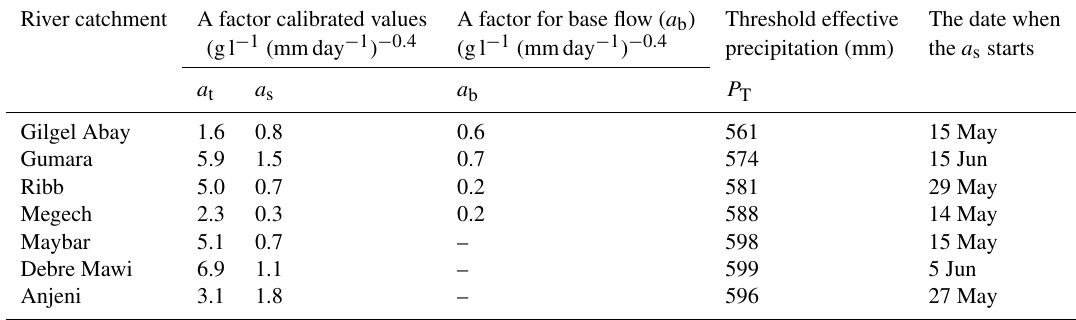
Table 2. The calibrated sediment rating curve parameters and the specific dates where the sediment transport ends and the sediment limiting phase starts. River catchment A factor calibrated values A factor for base flow ( a b ) Threshold effective